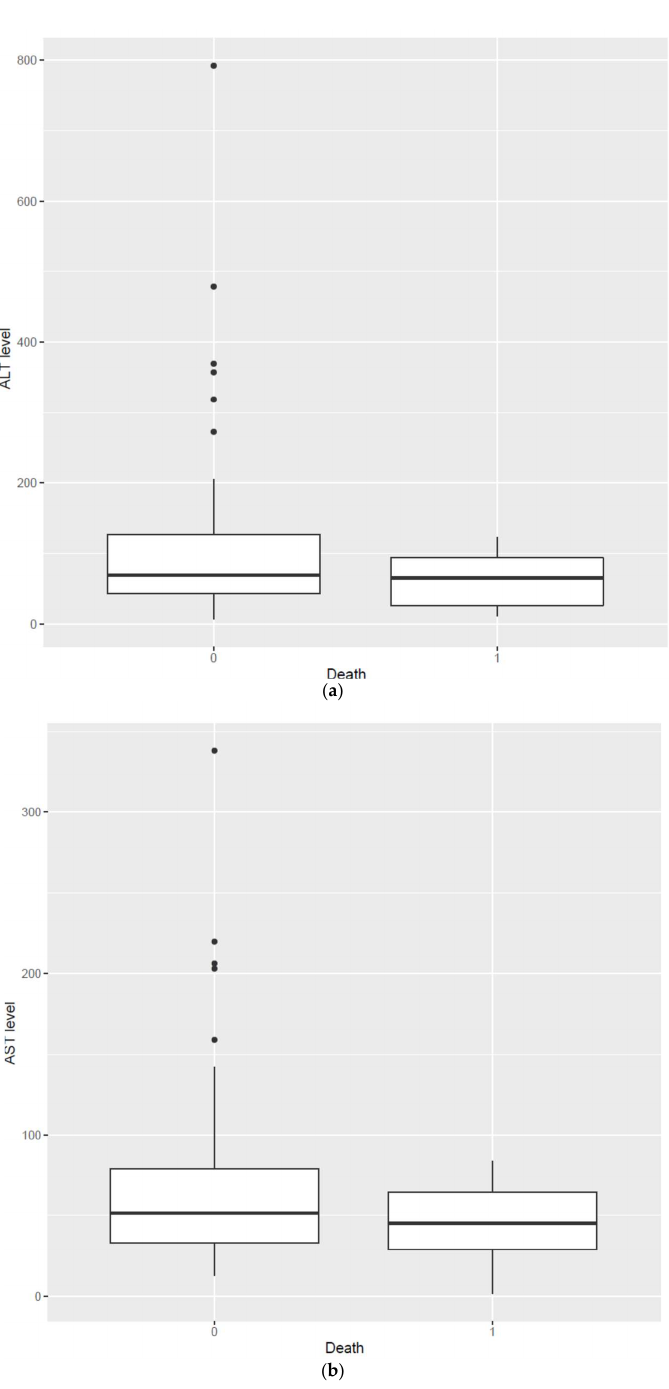
Figure 1. ( a ) ALT activity: second measurement (seven days after admission) in patients with parenchymal and mixed liver injury. First component: COVID-19 survivors. Second component: patients who eventually died of COVID-19. ( b ) AST activity: second measurement (seven days after admission) in patients with parenchymal and mixed liver injury. First component: COVID-19 survivors. Second component: patients who eventually died of